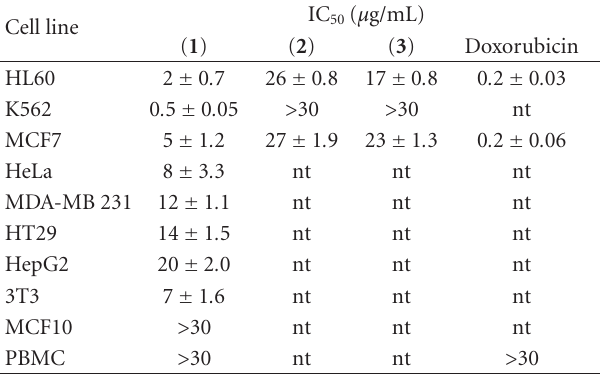
singlets at δ 6.12 (H-6) and 6.49 (H-3 (cid:3) ), and another high field resonance at δ 1.19 assigned to methyl group at